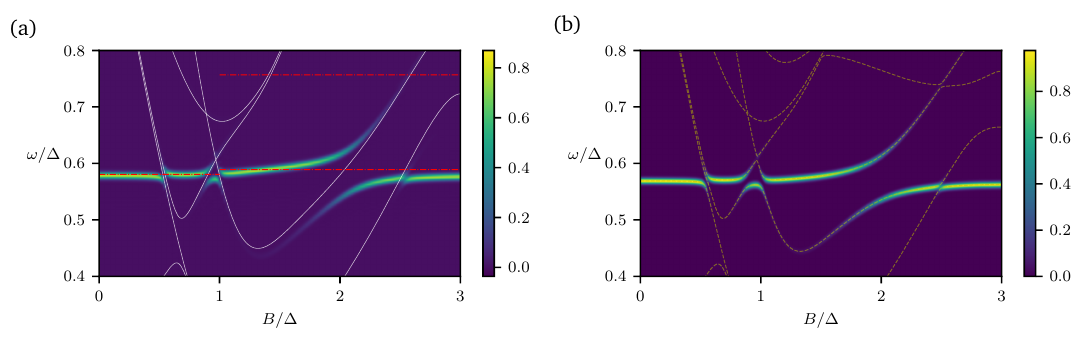
Figure 9: Energies of the ground state ( E state ( E ; green dashed line), obtained using the BdG spectrum, calculated for the 1 weak-link tight binding model (see Appendix A). Tight binding parameters used are the same as in Fig. 4, with a Zeeman energy B = 2 B in the spectrum at φ = π ,3 π allow us to define a 4 π -periodic ground state energy E , plotted as the solid red line. 4 π